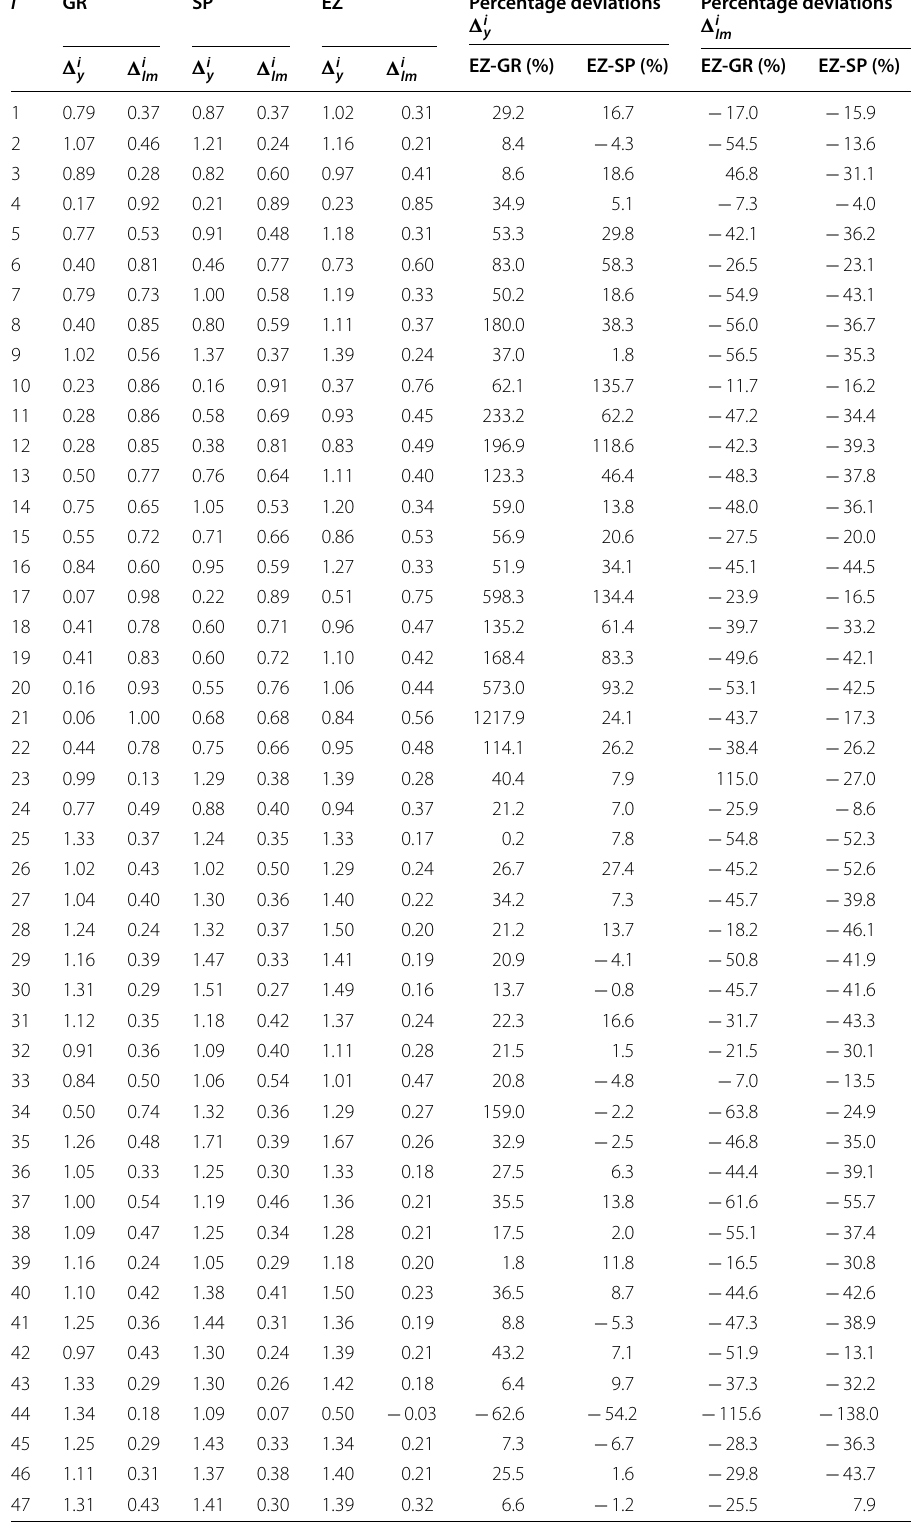
Table 1 Output and import multipliers and their percentage